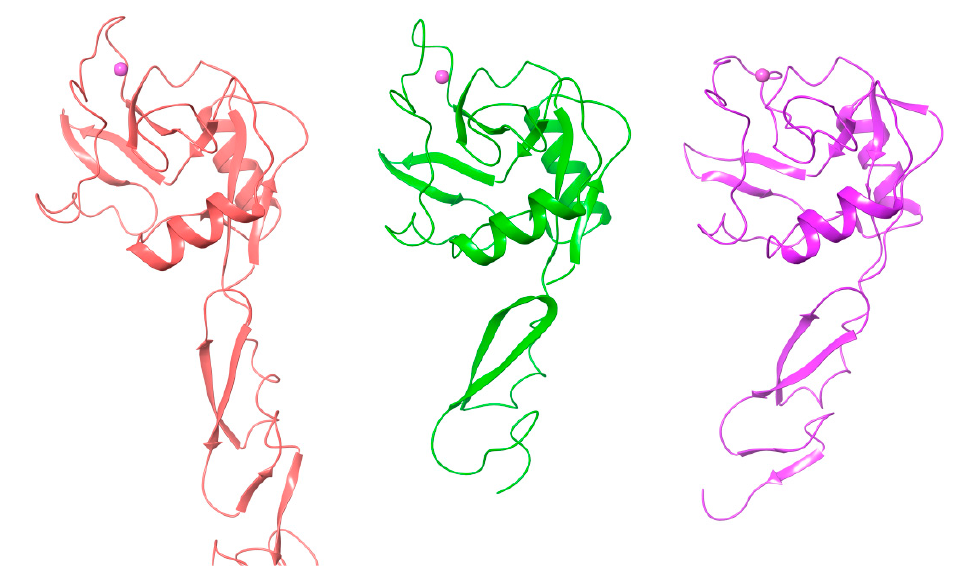
Figure 2. The 3-D structure of P-selectin (purple, PDB 1g1r [36]), E-selectin (red, PDB 4cs [36]), and L-selectin (green, PDB 3cfw [37]).